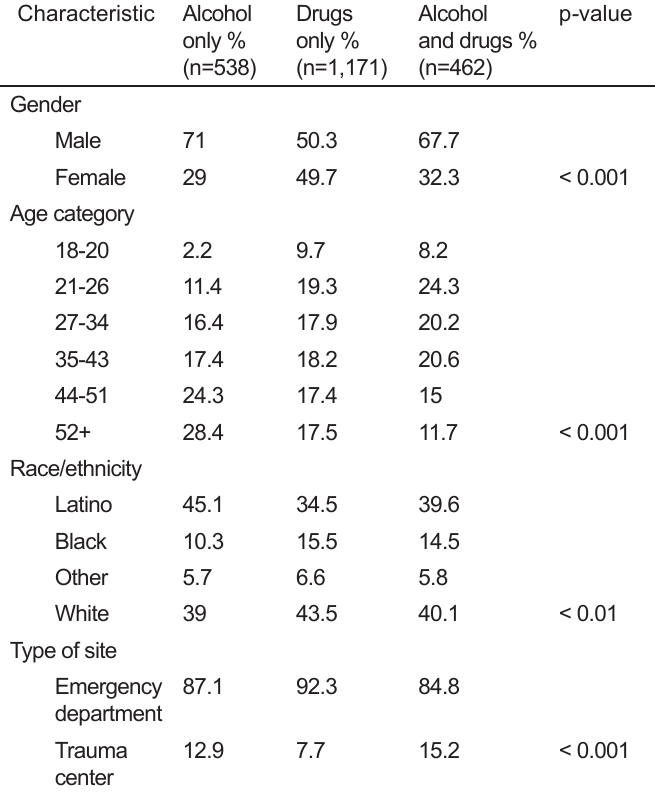
Table 2. Demographic characteristics of alcohol only, drug only, and alcohol and drug misusers (intent-to-treat sample [ITT]). Characteristic